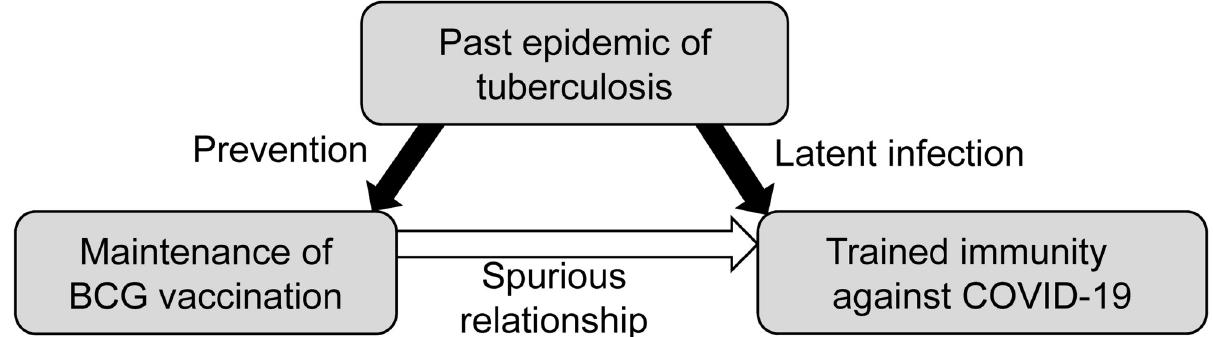
Fig 1. The hypothesis of trained immunity in latent tuberculosis